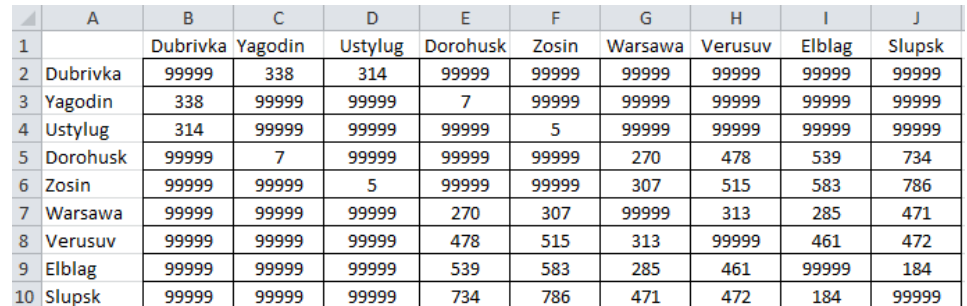
Figure 6: Starting matrix of distances between cities